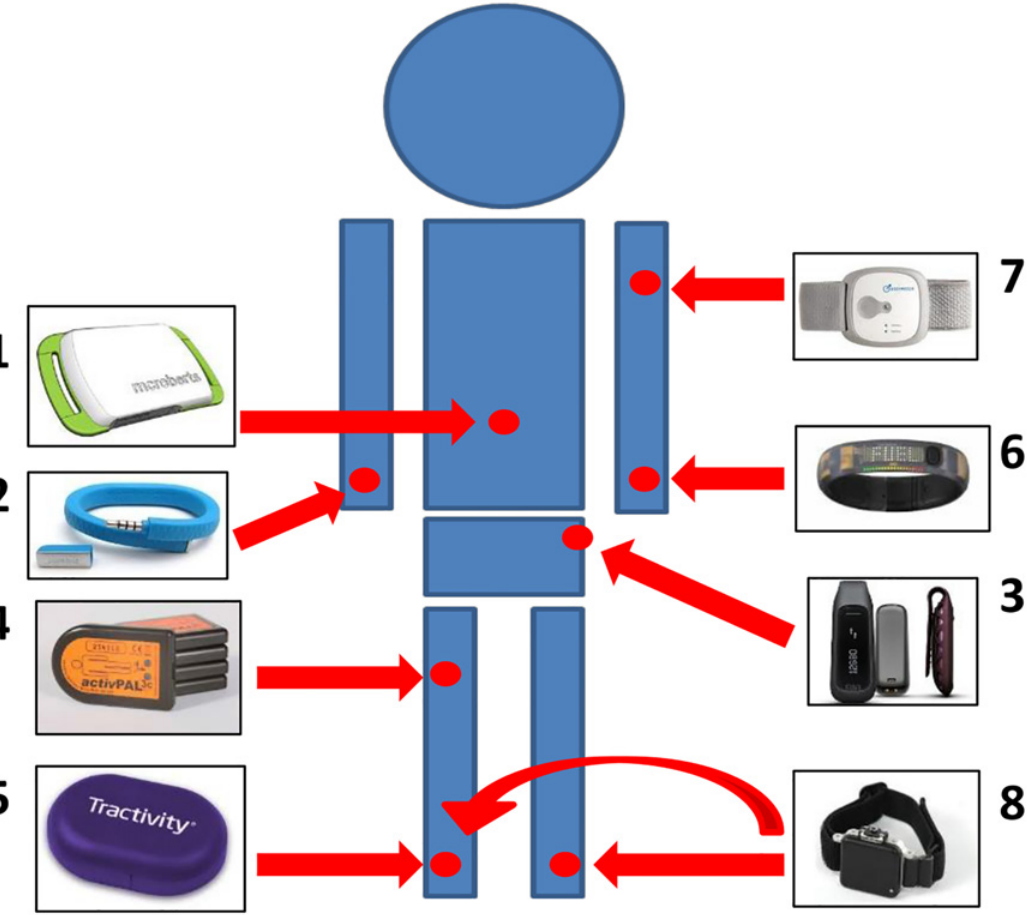
Fig 1. Sensor placement. The figure shows the location of the sensors on a subject ’ s body: Movemonitor (1), Up (2), One (3), ActivPAL (4) Tractivity (5), Nike+ Fuelband (6), Sensewear Armband Mini (7), OPAL